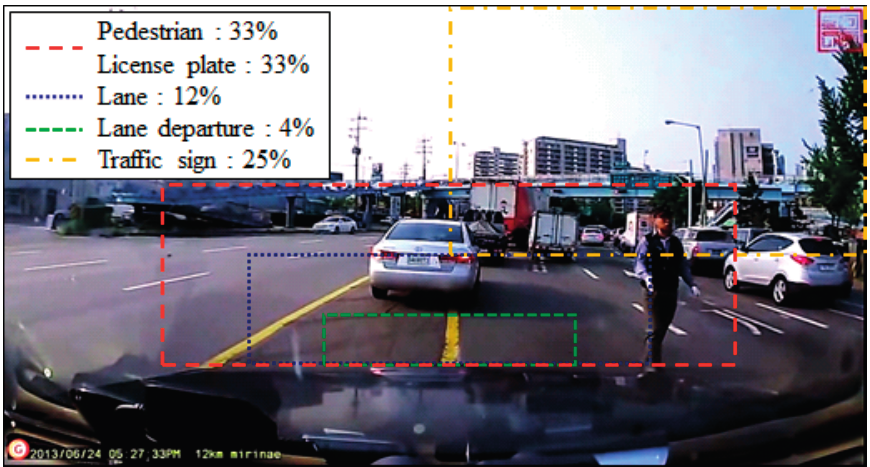
Figure 3. Size of static ROI for recognizing objects on the